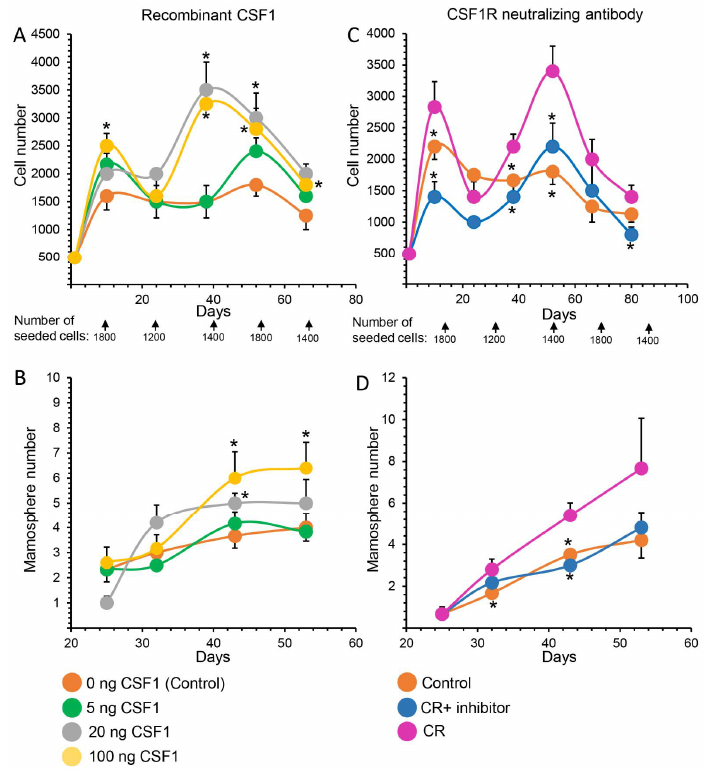
Figure 8. Manipulating the CSF1–CSF1R interaction affects mammary epithelial stem cell (MaSC) self-renewal. ( A ) Latent dose-dependent inductive effect of recombinant CSF1 on cell-propagation rate in cultures initiated by MaSCs. MaSCs (350 cell/well) were seeded in 96-well plates. Recombinant CSF1 was supplemented for the first 8 days in culture (days 1 and 4). Cells were counted and re-seeded in fresh medium at the indicated times. ( B ) Dose-dependent effect of CSF1 on mammosphere formation. Cells were incubated with CSF1 as described in Panel A and mammosphere generation was recorded at the indicated times. ( C ) Time course analysis of the latent effect of CSF1R-neutralizing antibody on cell-propagation rate in cultures initiated by MaSCs. Conditioned medium was collected from CD14 high CD24 neg monocyte/macrophage cultures of 10,000 cells/well containing in 100 μL medium. CSF1R-neutralizing antibody (10 μg/mL) was added for the first 8 days of culture (days 1 and 4). For details see Panel ( A ). ( D ). Dose-dependent effect of CSF1R-neutralizing antibodies (10 μg/mL) on mammosphere formation from MaSCs. For details see Panel ( C ). Dots represent mean ± SEM of 5 replications. * p < 0.05.